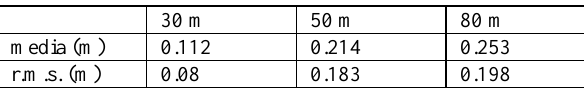
Table 5. Statistical results of vines